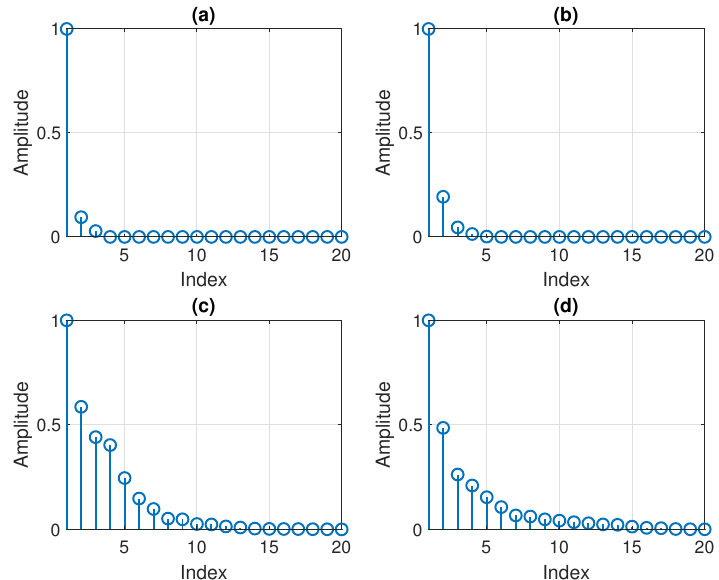
Figure 2. Singular values of the matrix H of size L 1 × L 2 (normalized with respect to the maximum one), with L 1 = 25 and L 2 = 20, corresponding to: ( a ) the impulse response from Figure 1a; ( b ) the impulse response from Figure 1b; ( c ) the impulse response from Figure 1c; and ( d ) the impulse response from Figure